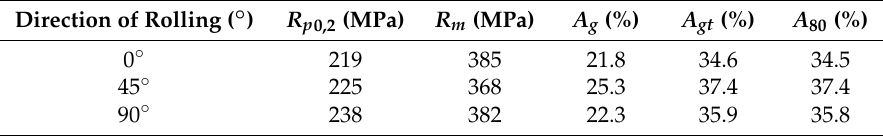
Table 7. Mechanical properties of